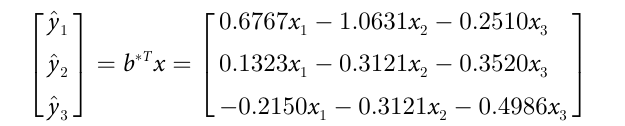
Table 1. t test statistics value of b �